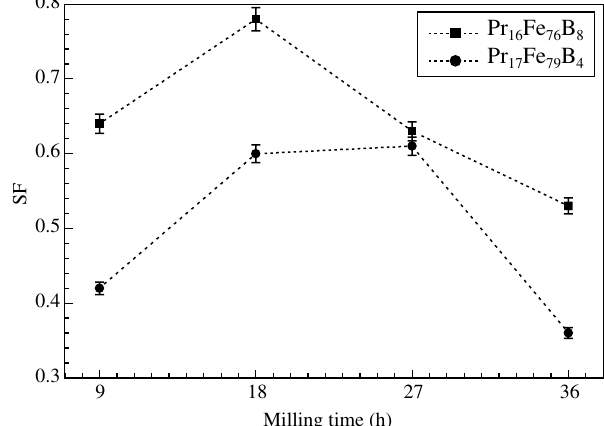
Figure 2. Remanence of Pr of milling time.